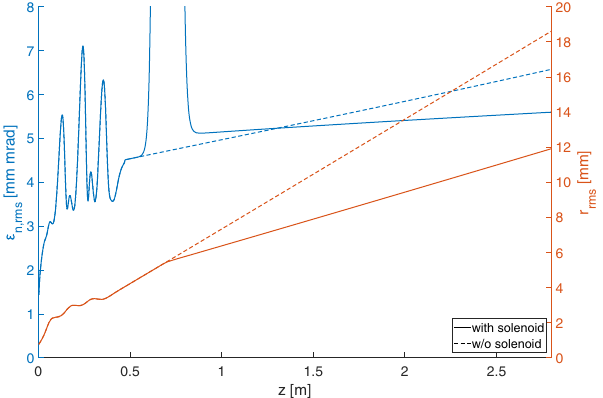
FIG. 11. Tracking of a 250 pC bunch through the ELBE SRF Gun and along the first 2.8 meters of the beamline without rf focusing. The dashed curves give the evolution of beam radius and transverse emittance without active SC solenoid after the resonator while for the solid curves the solenoid field was optimized for a minimum emittance at the end. The strong peak in the emittance curve at the solenoid ’ s location describes the temporary blowup of the transverse trace space caused by the rotation of the electron bunch in the magnet.